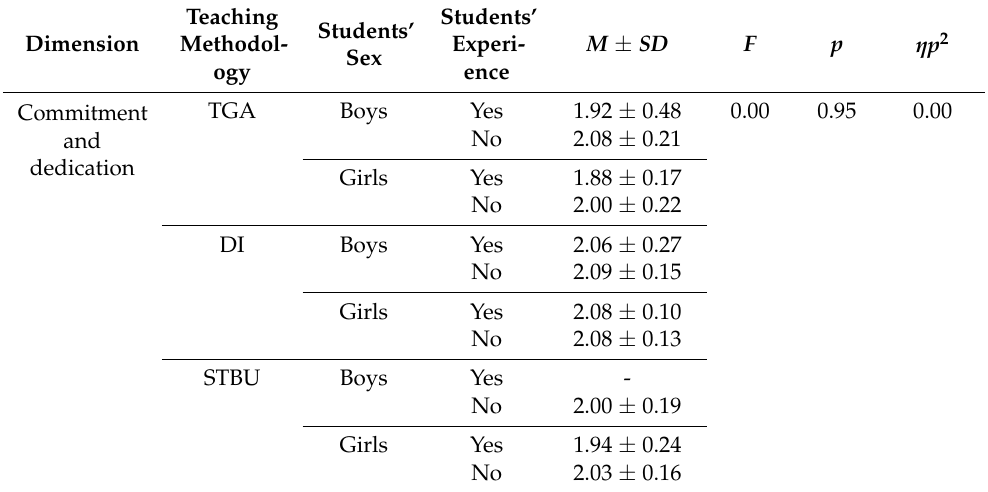
Table 4. Effects of the students’ sex and experience on the methodologies applied (multiple interaction).